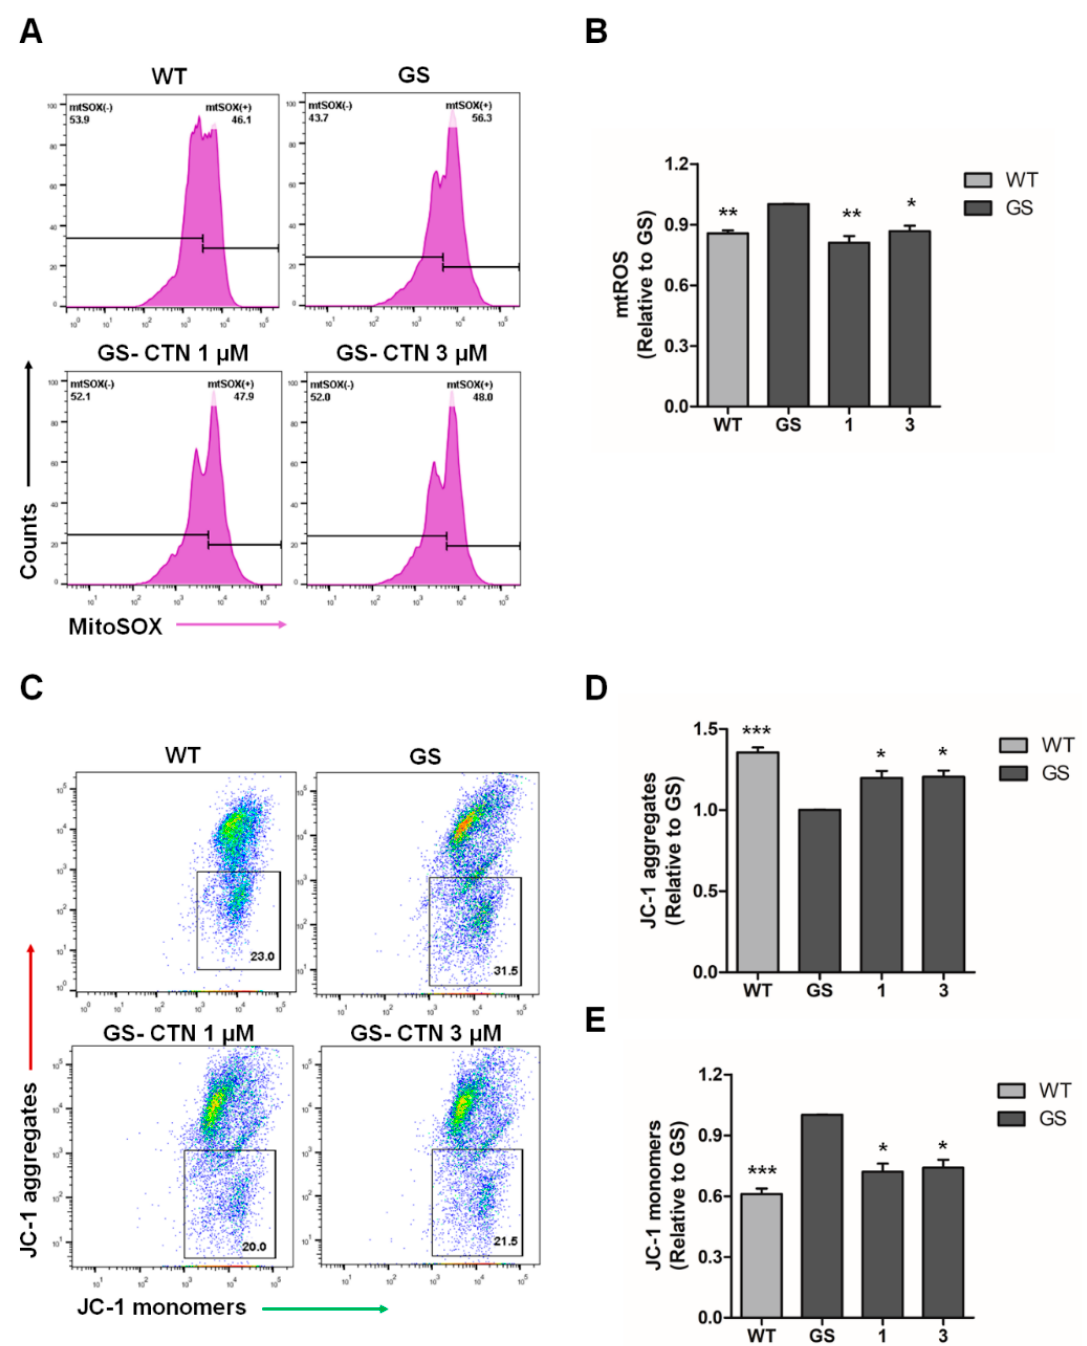
Figure 4. Evaluation of the regulation of mitochondrial functions by CTN treatment under MG132-induced oxidative stress. ( A ) MG132-induced increases in mitochondrial reactive oxygen species (ROS) levels and restoration by CTN treatment as analyzed by MitoSOX-based flow cytometry. ( B ) Quantification of mtROS levels. ( C ) Evaluation of mitochondrial membrane potential (MMP) through JC-1 aggregates and JC-1 monomer fluorescence intensity through flow cytometry. ( D ) Quantification of JC-1 aggregates population. ( E ) Evaluation of JC-1 monomers. Data are mean ± standard error of means (SEM) of at least three independent experiments. p -values were analyzed using the unpaired two-tailed Student’s t -test (* p < 0.05, ** p < 0.005, *** p < 0.001).